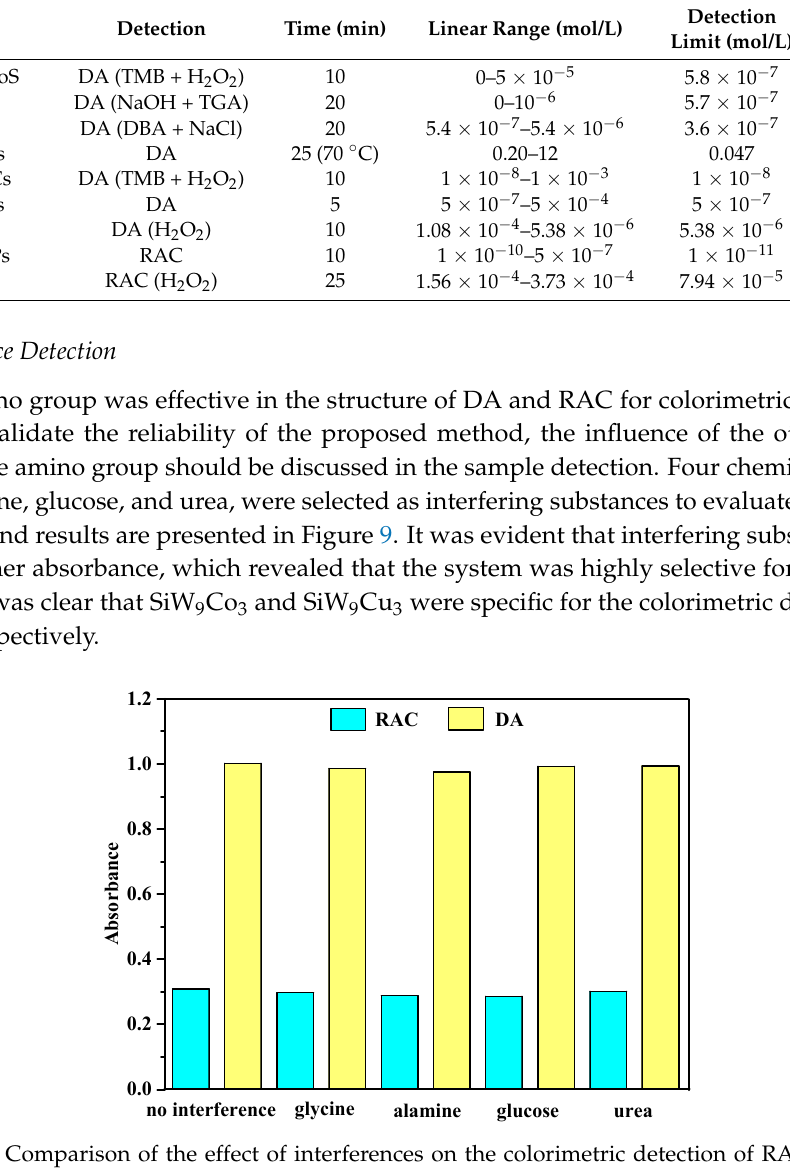
Table 1. Comparison of DA and RAC obtained by different colorimetric catalysts in recent years. AuNPs: Au nanoparticles. AgNRs: Ag nanoparticles TMB: 3,3 ′ ,5,5 ′ -tetramethylbenzidine. DBA: